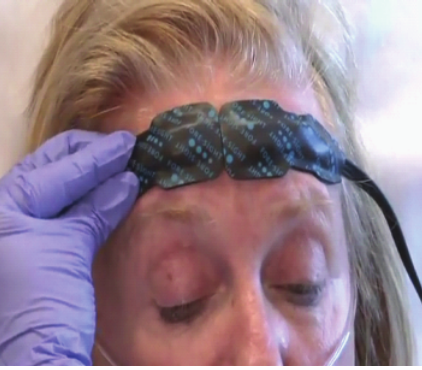
Figure 3: The Clotbust ER ultrasound system for thrombolysis. Courtesy of Cerevest Therapeutics Inc.